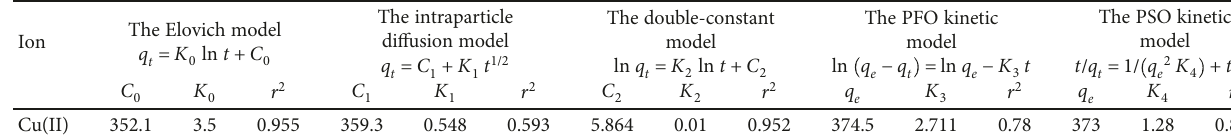
Table 3: Fitting parameters of kinetic models to Cu(II) adsorption.